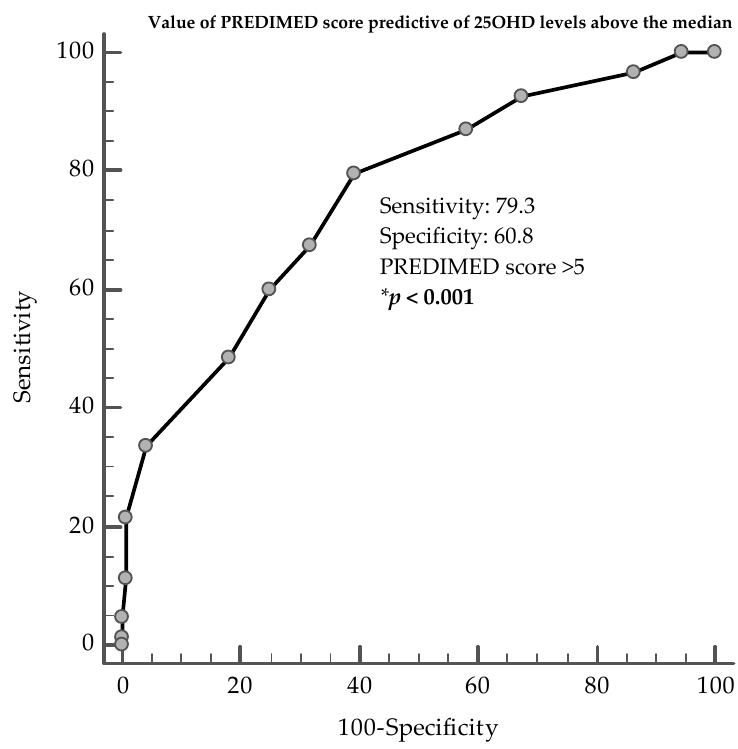
Figure 3. ROC for value of PREDIMED score predictive of 25OHD levels above the median, in males. * A p -value in bold type denotes a significant difference ( p < 0.05).